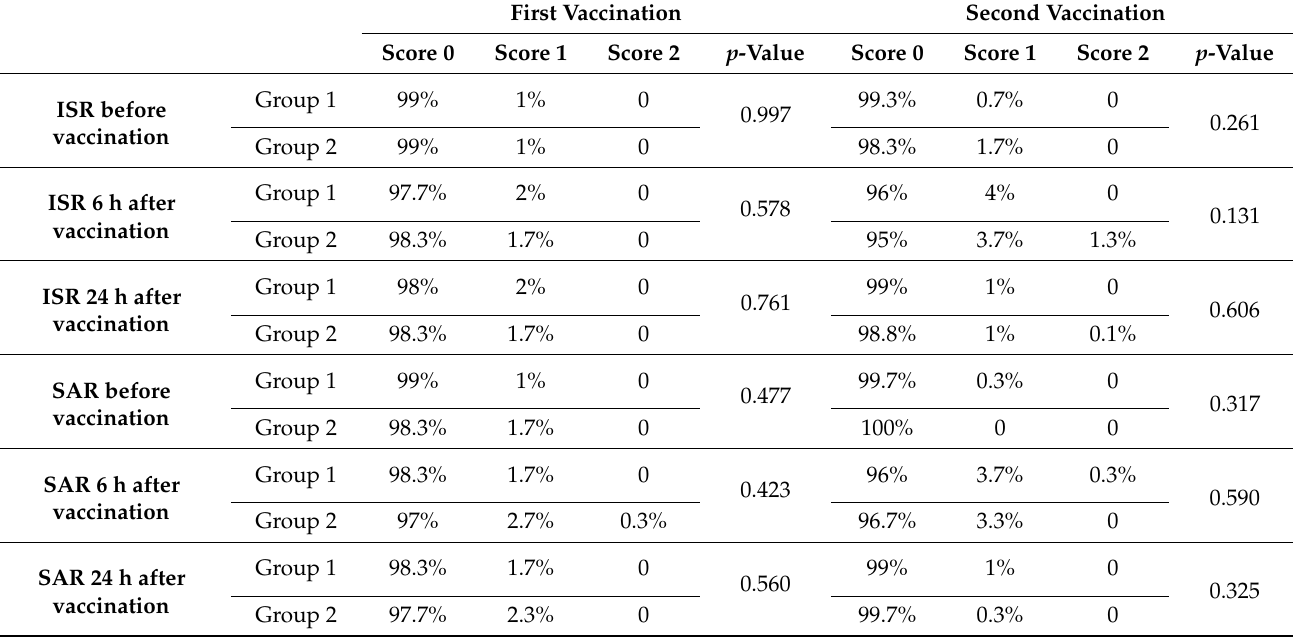
Table 4. ISR and SAR after first and second